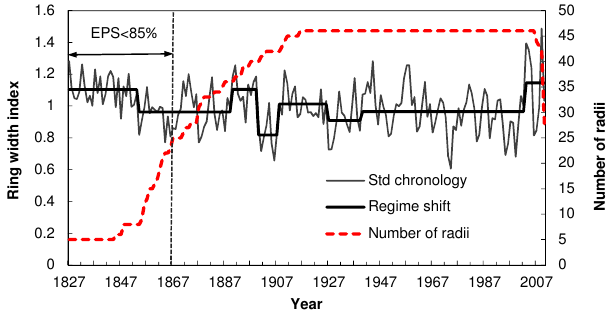
Figure 5. Tree-ring standard chronology of Abies spectabilis from the Kalchuman Lake area of Manaslu, central Nepal.